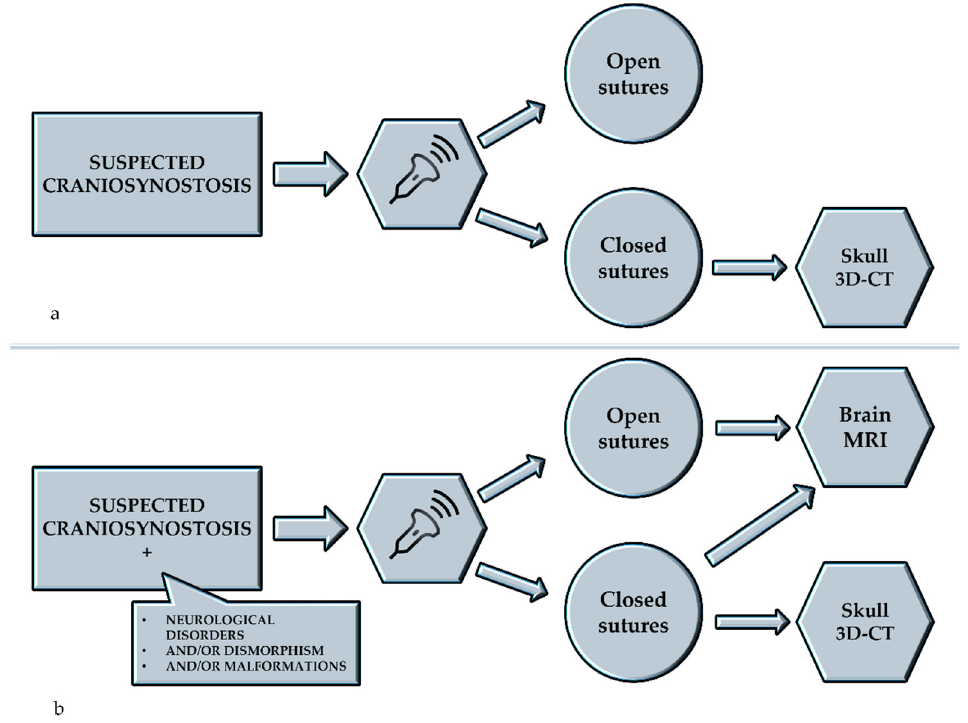
Figure 2. Management of cases of suspected craniosynostosis starting with ultrasonographic exam- ination: ( a ) suspected craniosynostosis alone; ( b ) suspected craniosynostosis associated with other conditions. 3D-CT: three-dimensional computed tomography, MRI: Magnetic Resonance Imaging.